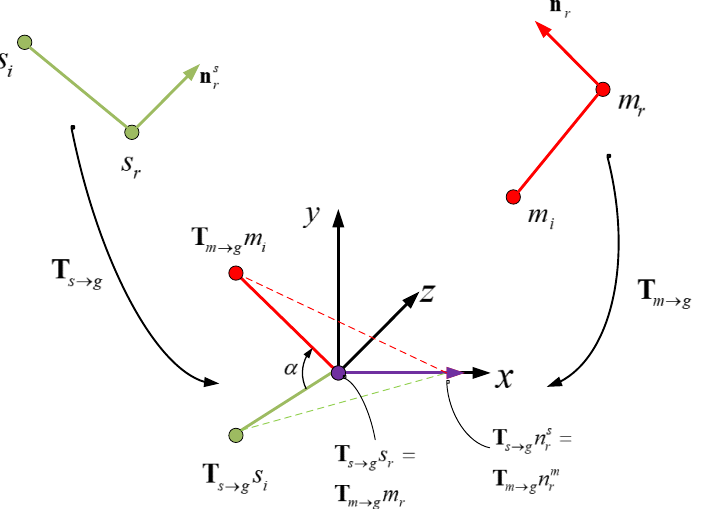
Figure 6. Transformation between model point-pairs and scene point-pairs. The transformation relationship R x ( α ) is obtained by aligning the point-pair vector and its normal